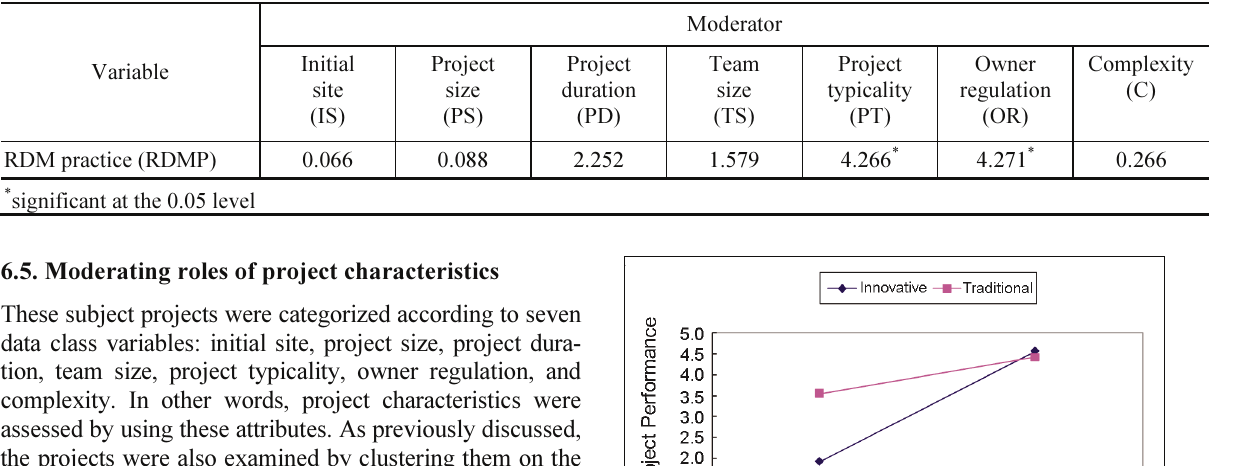
Table 6. Results of two-way ANOVAs